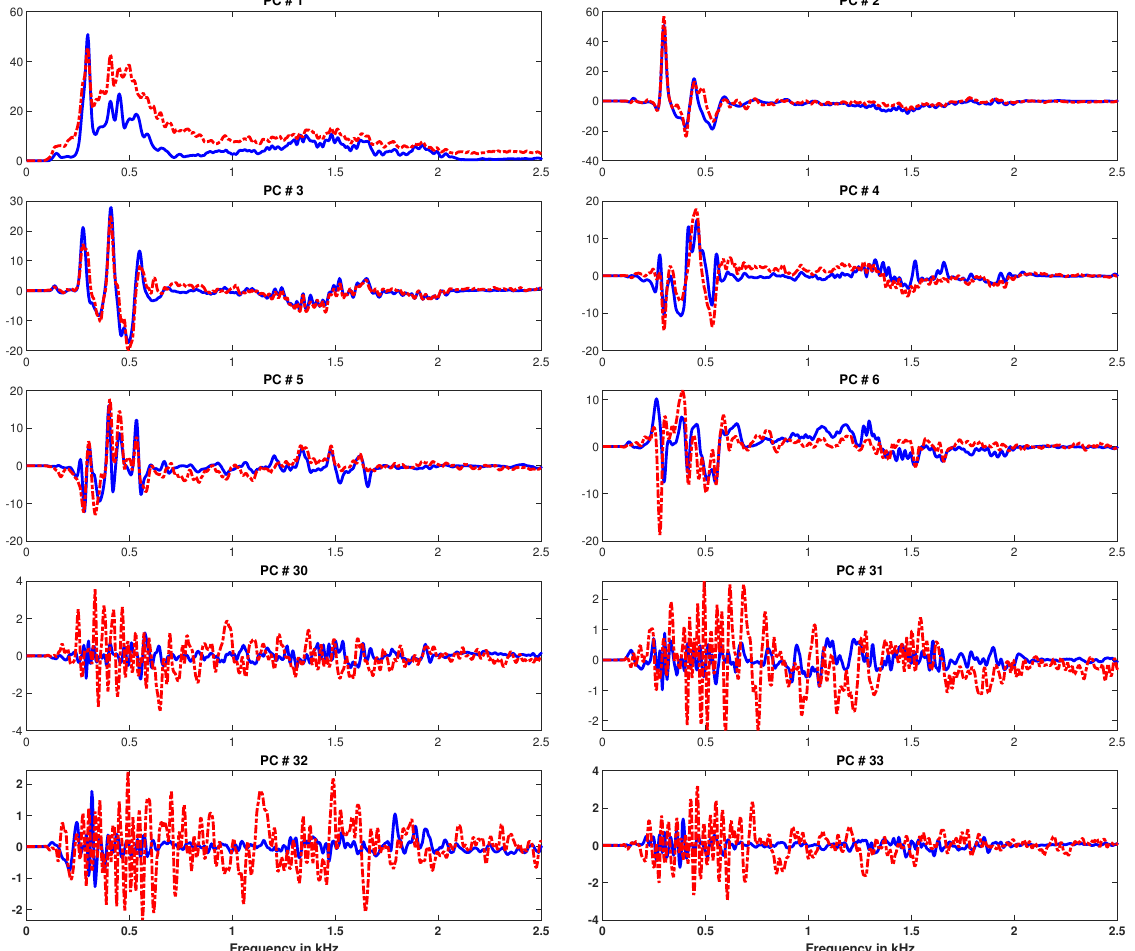
Figure 3. The principal components of the STFTs of clean (in solid blue) and noisy (in dash-dotted red)